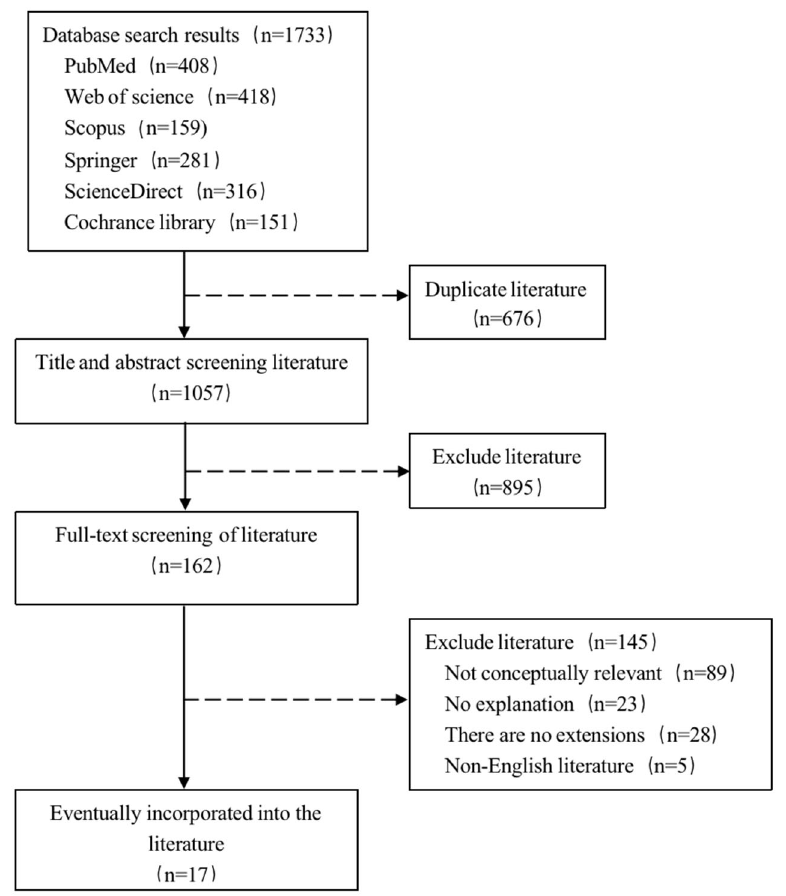
Figure 1. The literature search process.